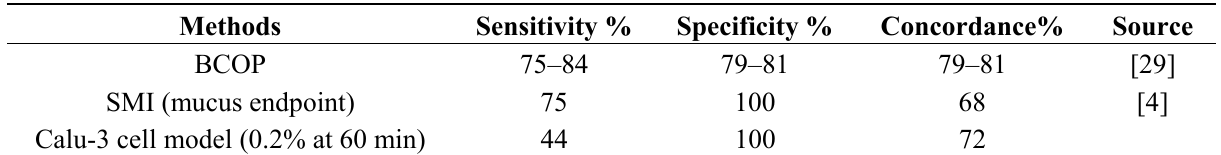
Table 6. Comparison of sensitivity, specificity and concordance of different assay methods used in prediction of mucosal